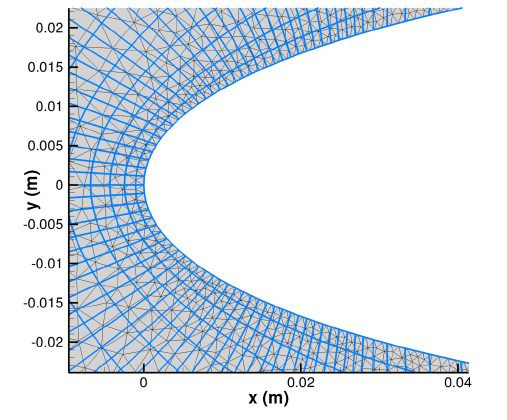
Figure A2. Meshes used for the simulation of the Han and Palacios test case. Default structured mesh in blue lines, coarsest unstructured mesh in black